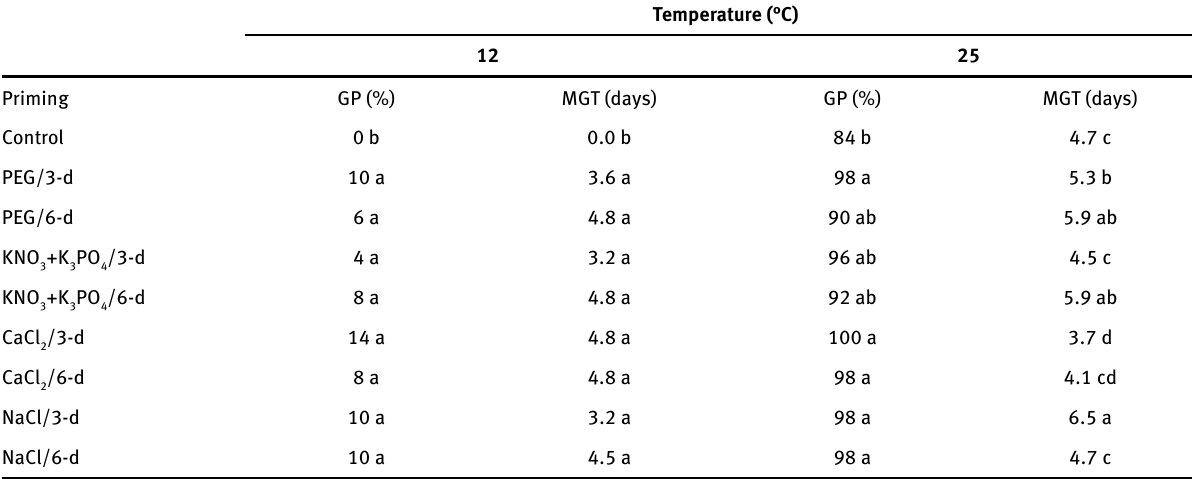
Table 1: Effect of different osmotic agents and priming durations on germination percentage (GP) and mean germination time (MGT) of melon seeds at 12 and 25°C